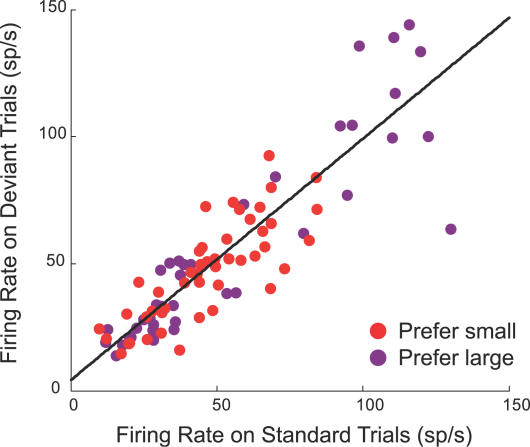
Numerical Sensitivity in LIP Does Not Reflect Attention or Reward ExpectationsFor 31 neurons significantly modulated by number, the average response was compared for sets of trials in which a particular number was presented as both standard and deviant in the same recording session. The line shows the best fit to the data with an intercept of 5.5 sp/s and a slope of 0.92.